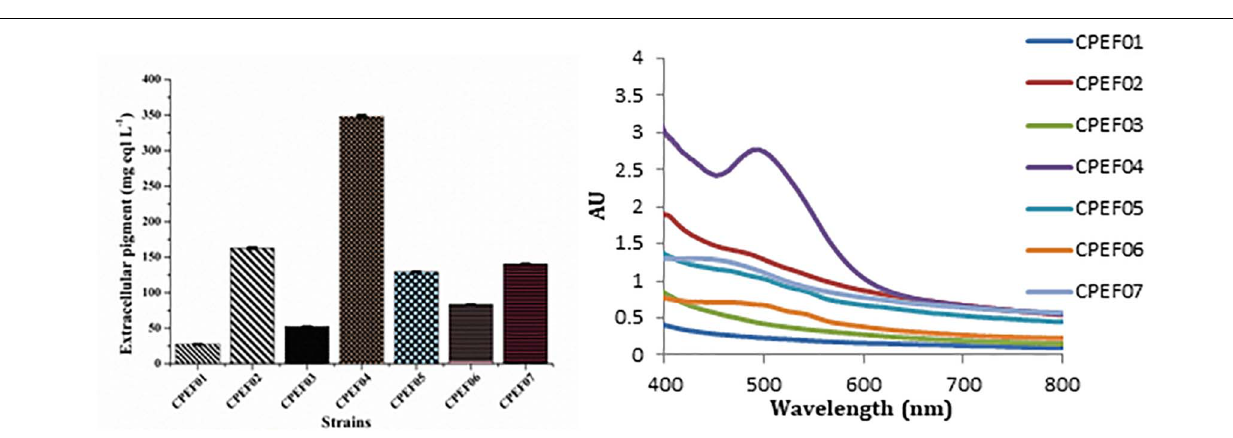
FIGURE 2 | UV–visible absorption spectra of seven different isolates and a comparison of the extracellular pigments produced (mg eqv. carmine L − 1 ) by these